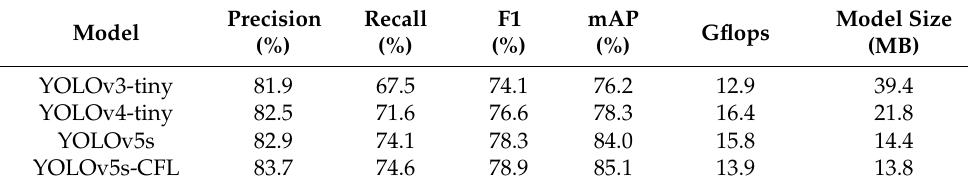
Table 1. Comparison of different detection models on the Capsicum frutescens L.